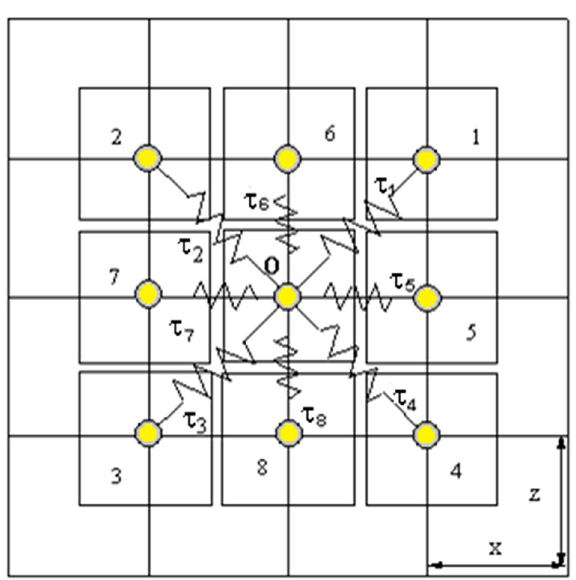
Figure 9. 2D spring model for the interface between the tip of the needle and the liver 65